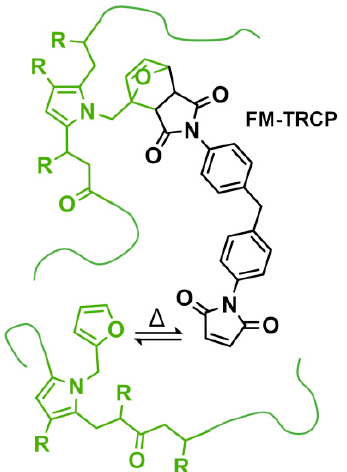
Figure 2. Prepared FM-TRCP: furan-grafted polyketone thermo-reversibly crosslinked with MDP- BMI. R stands for hydrogen and methyl groups.